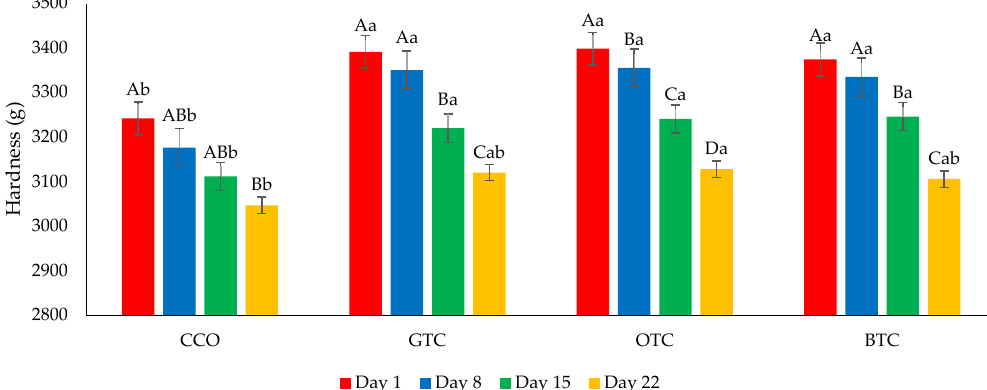
Figure 6. The hardness of non-gluten shortbread cookies with various spent tea leaf powders during different storage periods (day 1, 8, 15, and 22) at 25 ◦ C. The mean ± SD ( n = 3). Different letters indicate significant differences between the values (Duncan’s multiple range test, p < 0.05, a,b cookie samples, A–D storage). CCO = control; GTC = non-gluten shortbread cookies with spent green tea leaves powder; OTC = non-gluten shortbread cookies with spent oolong tea leaves powder; and BTC = non-gluten shortbread cookies with spent black tea leaves powder.